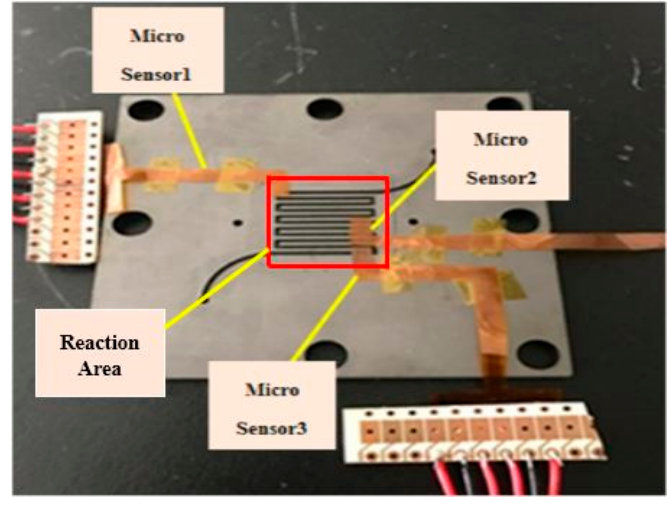
Figure 11. Schematic diagram of flexible four-in-one microsensor embedded in a cathode channel plate.